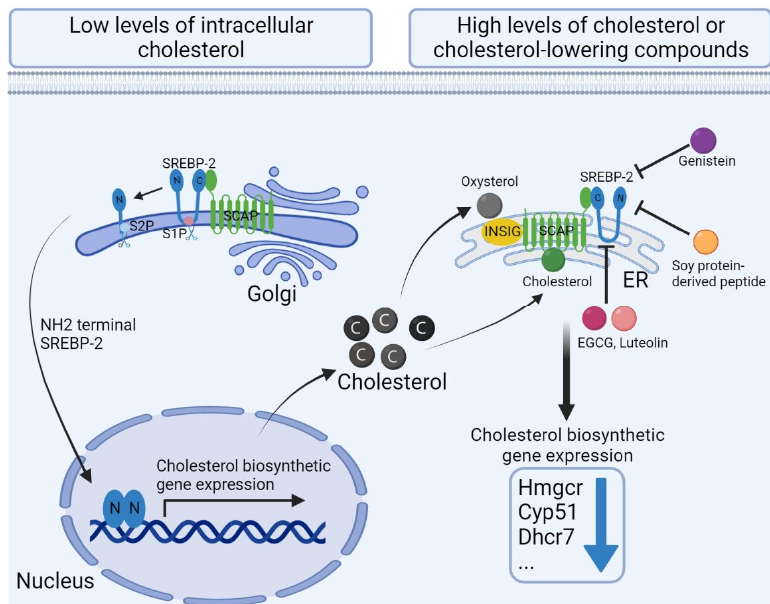
Figure 2. The role of sterol regulatory element-binding protein (SREBP)/SREBP-cleavage-activating protein (SCAP) in the regulation of cholesterol synthesis. When the levels of intracellular cholesterol are low, SREBP-2/SCAP complex is transported from endoplasmic reticulum (ER) to the Golgi ap- paratus and processed to release the NH2-terminal fragment of SREBP-2 (nSREBP-2). nSREBP-2 is translocated into the nucleus to induce expression of genes related with mevalonate pathway, that increasing cholesterol synthesis. When the levels of intracellular cholesterol are high, SCAP forms a complex with insulin-induced gene 1 (INSIG1) and SREBP-2, and remains inactive in the ER. Oxys- terols bind INSIG, that also leads to form the SREBP-2/SCAP/INSIG complex and thereby prevents SREBP-2 processing. Several polyphenols, e.g., epigallocatechin gallate (EGCG) and luteolin, and soy protein derived peptides, could inhibit SREBP2 expression, reducing cholesterol synthesis. A soy-derived flavonoid, genistein, inhibits the processing and the nuclear translocation of SREBP2. hood and the adult years; however, in most instances, exogenous cholesterol from foods is also consumed in addition to endogenously synthesized cholesterol. The intestinal cho- lesterol absorption rate is estimated to vary from approximately 25% to 85% in the amount of dietary cholesterol intake, but is approximately 50% on average [24].